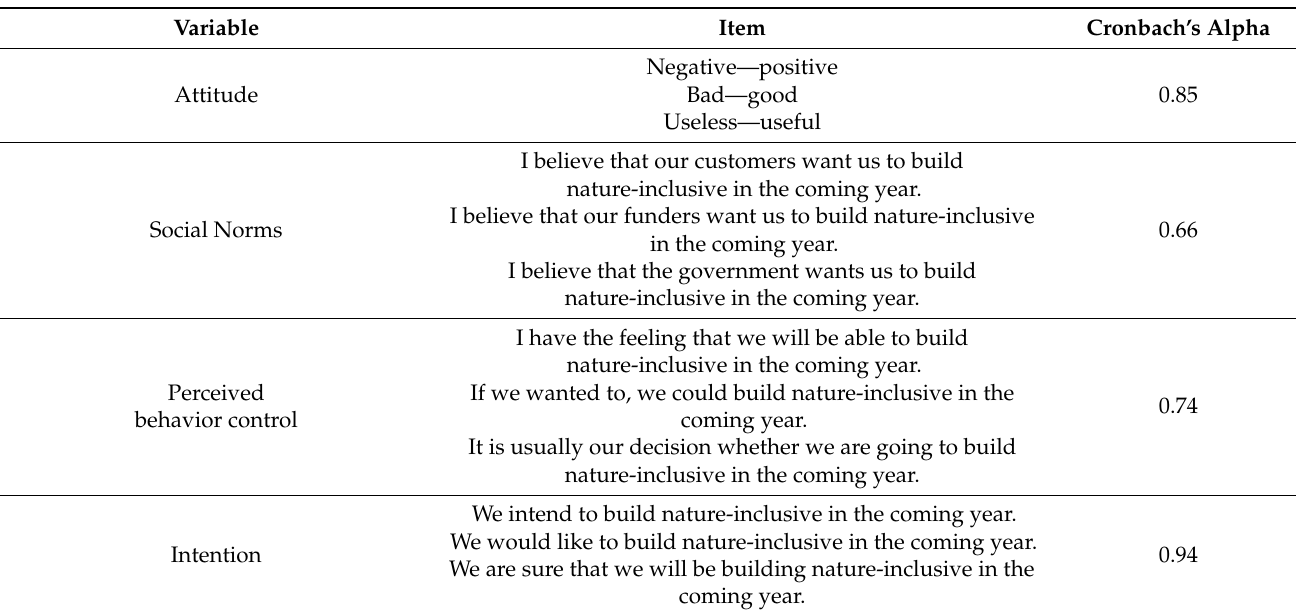
Table 1. Items of the TPB’s